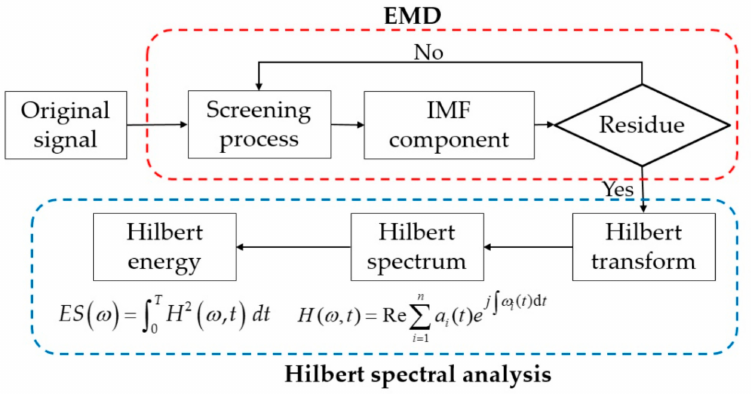
Figure 7. The process diagram of the Hilbert–Huang conversion